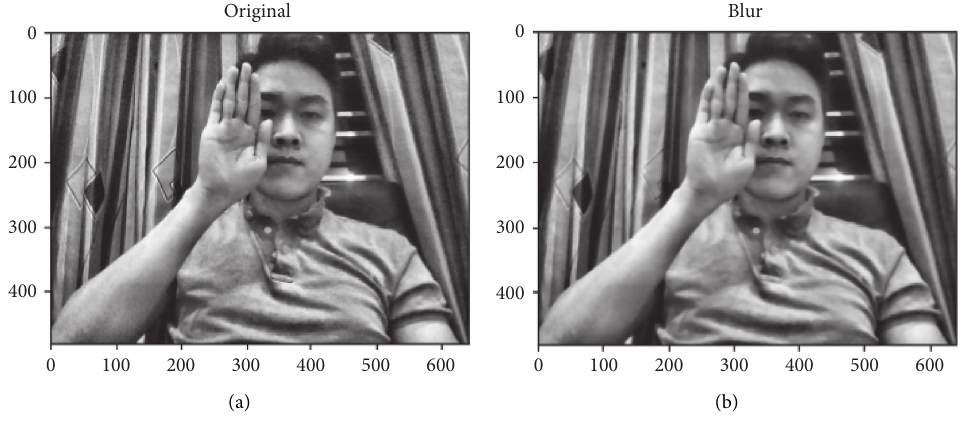
Figure 9: Images before and after filtering median.